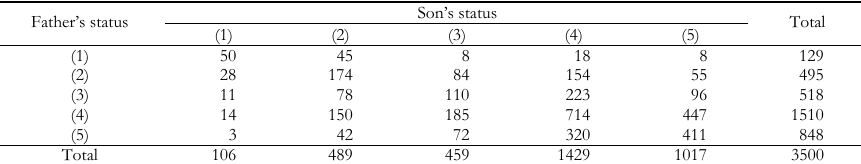
The data are cross-classification of father’s and his son’s social classes in British (Agresti, 1984, p. 206)